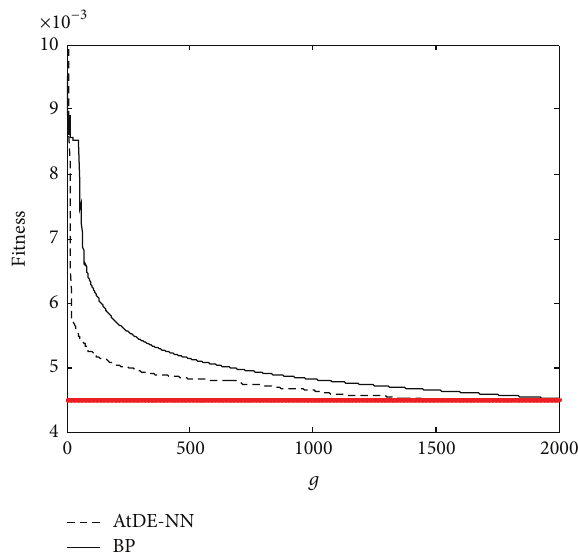
Figure 5: Convergence speed comparison between BP neural net- work and AtDE neural network.